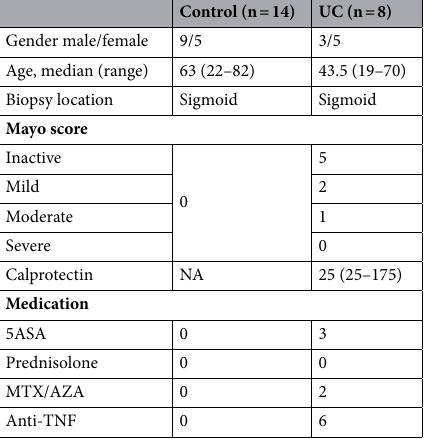
Table 2. Baseline characteristics of study participants used in ex vivo biopsy model n = 22. Continuous variables given as median with